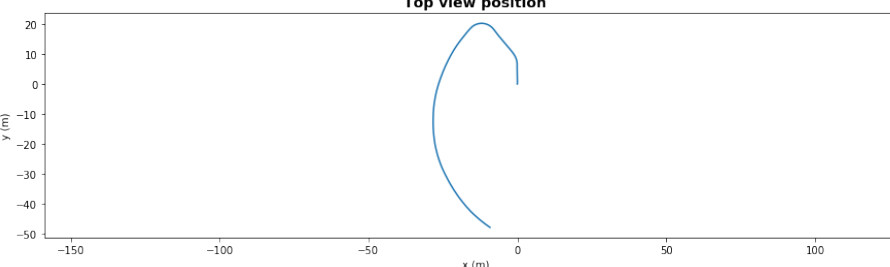
Figure 8. waypoint mission—path with mild degradation.